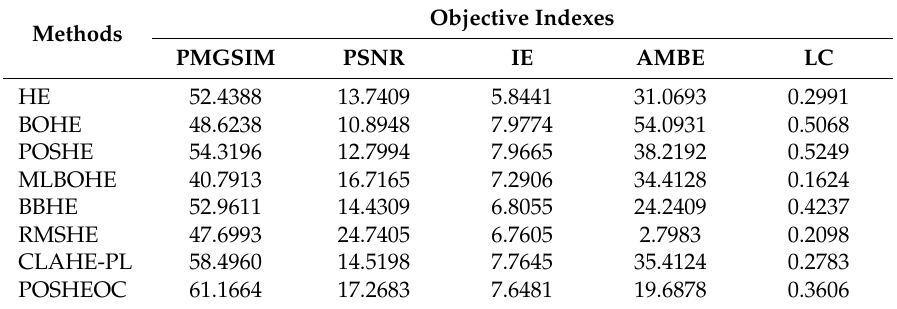
Table 2. Quantitative results for ultrasonic logging image of Changqingyi well with various methods.